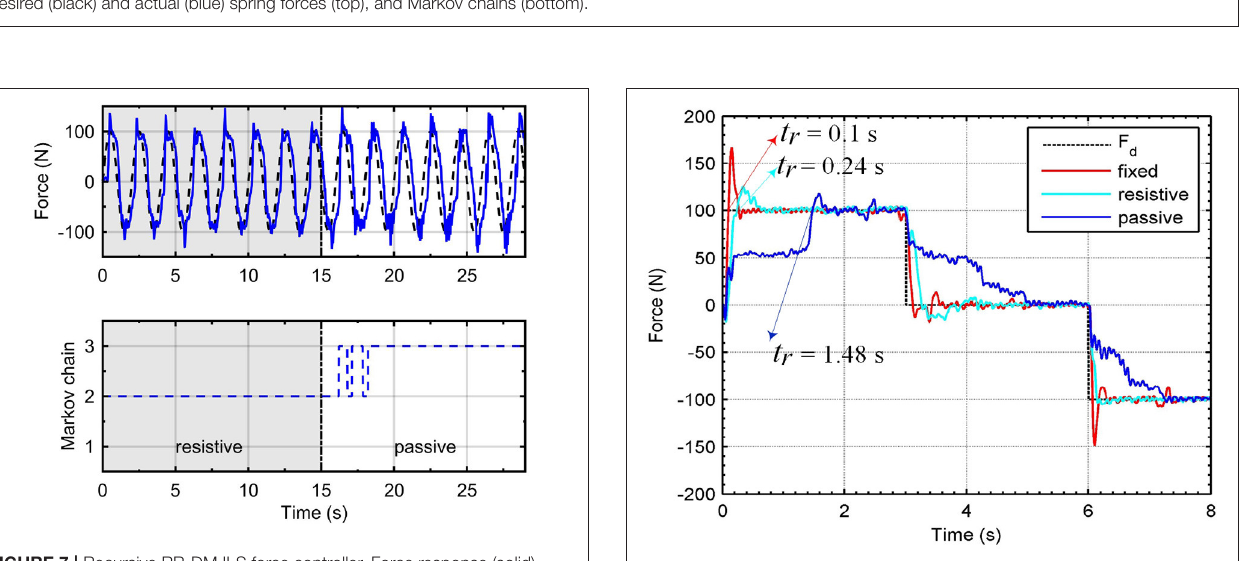
FIGURE 8 | Time response of the system with H ∞ force